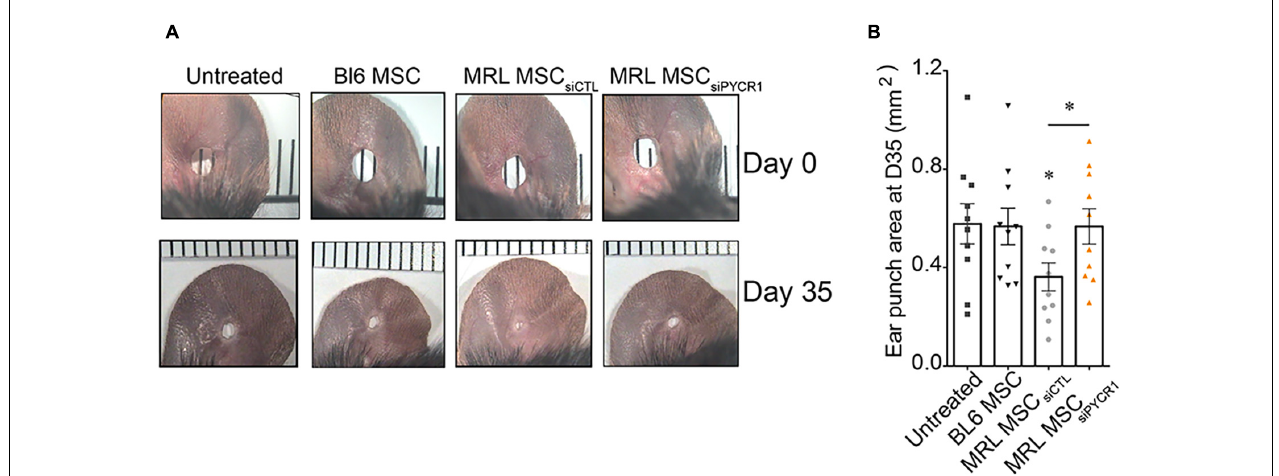
FIGURE 6 | MRL MSCs induce tissue regeneration in BL6 mice in a Pycr1 -dependent manner. (A) Pictures of the ear holes at day 0 and day 35 after wounding. The punch holes in the ears of BL6 mice were either untreated (untreated) or treated with MSCs. BL6 MSCs and MRL MSCs transfected with either siCTL (MRL MSC siCTL ) or siPYCR1 (MRL MSC siPYCR1 ) were injected at the wound edges. (B) Quantification of the ear punch hole closure at day 35 (D35) using the ImageJ program to define the ear punch area. Results represent the mean ± SEM. N mice = 10 per condition, Mann–Whitney test, two-tailed, when not indicated untreated versus MRL MSC siCTL , p -values < 0.05 ( ∗ ). MRL, Murphy Roths Large; MSC, mesenchymal stem